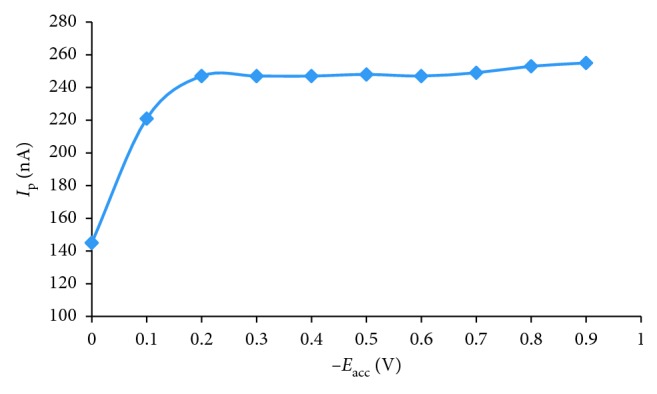
Effect of Eacc on the Ip for 10−7 mol·L−1 AO, tad = 60°s, f = 50 Hz.